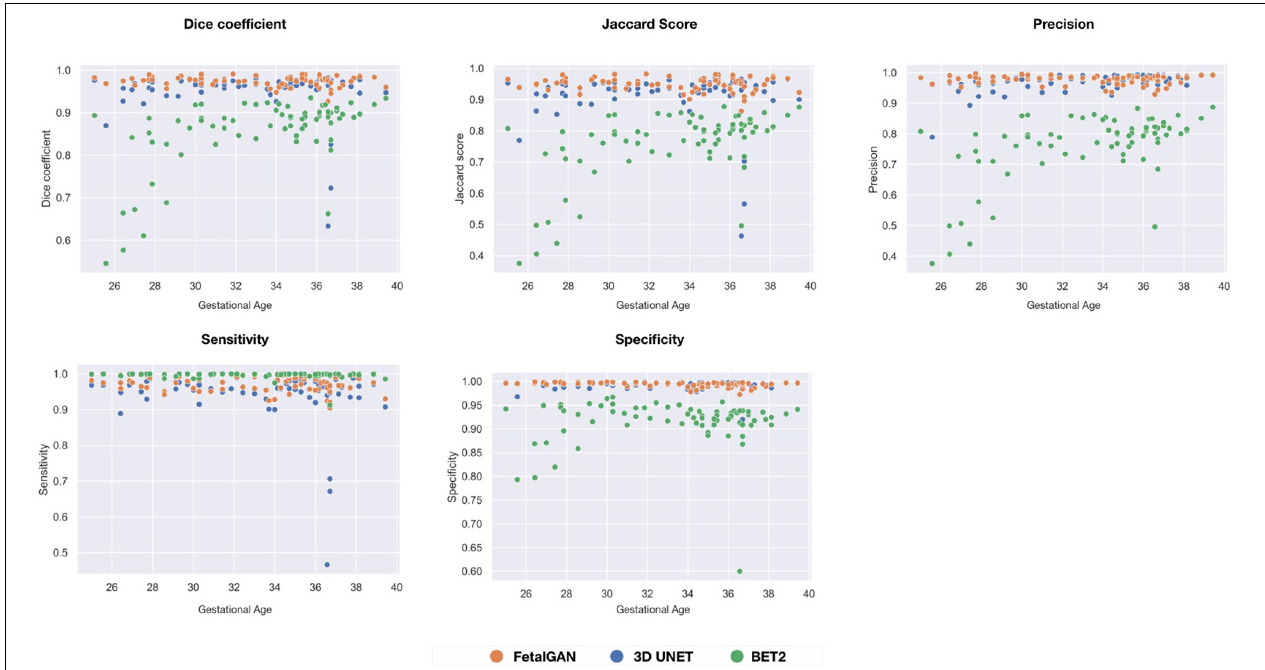
FIGURE 3 | Performance scores fo FetalGAN, 3D U-Net and BET2 methods across gestation ages: (A) Dice coefficient, (B) Jaccard Score, (C) Precision, (D) Sensitivity, and (E) Specificity.